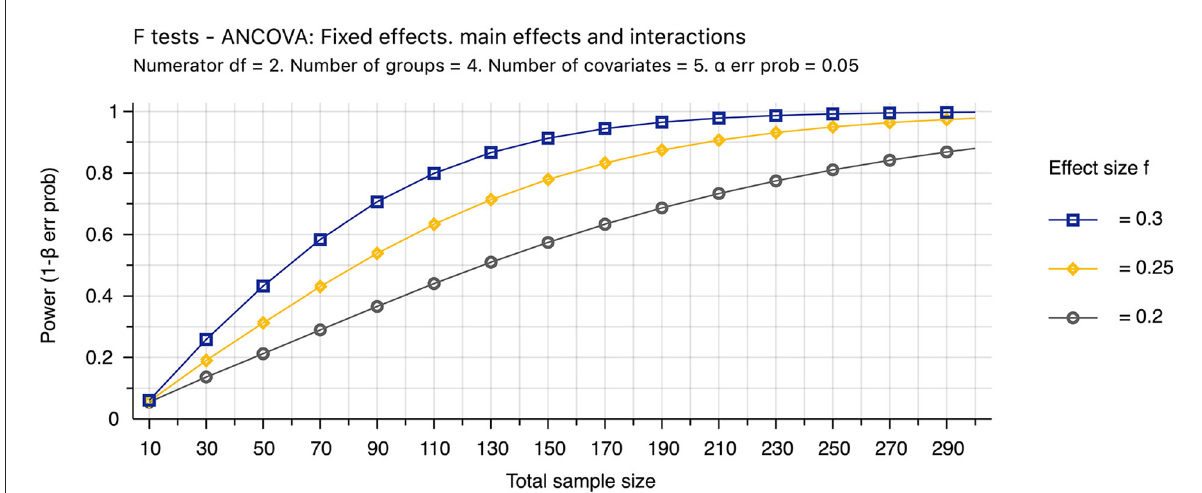
FIGURE4 Power analysis. The theoretic sample size was determined by the sensitivity value (effect size = 0.25) that further decreasing the effect size from 0.25 to 0.2 requires appreciably increasing the sample size from 251 to 390. The sample size assumes that 87% of data are valid ( N = 251/0.87 ∼ 288). Invalid data include MRI images with excessive motions and new conditions found after completion of the study, and the percentage was estimated empirically. The analysis of covariance (ANCOVA) will be used to determine the mean difference among four groups with 5 covariates of age, gender, activity levels, body mass index, depression, and anxiety. We assumed both type I and II errors of 0.05.